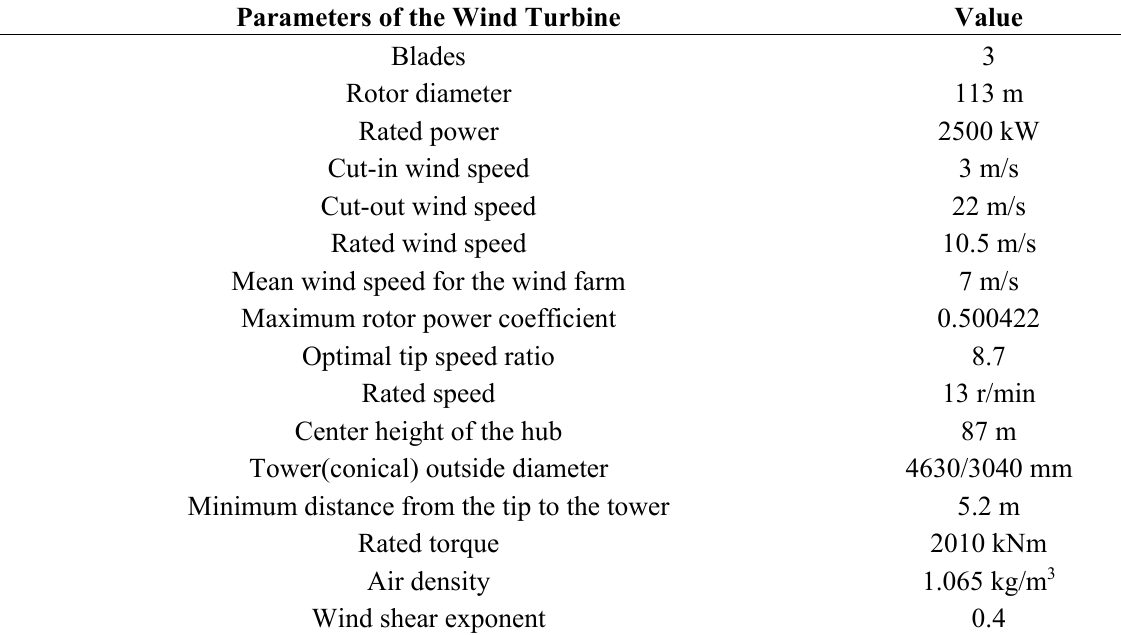
Table 2. Parameters of the 2.5 MW permanent-magnet direct-drive synchronous wind